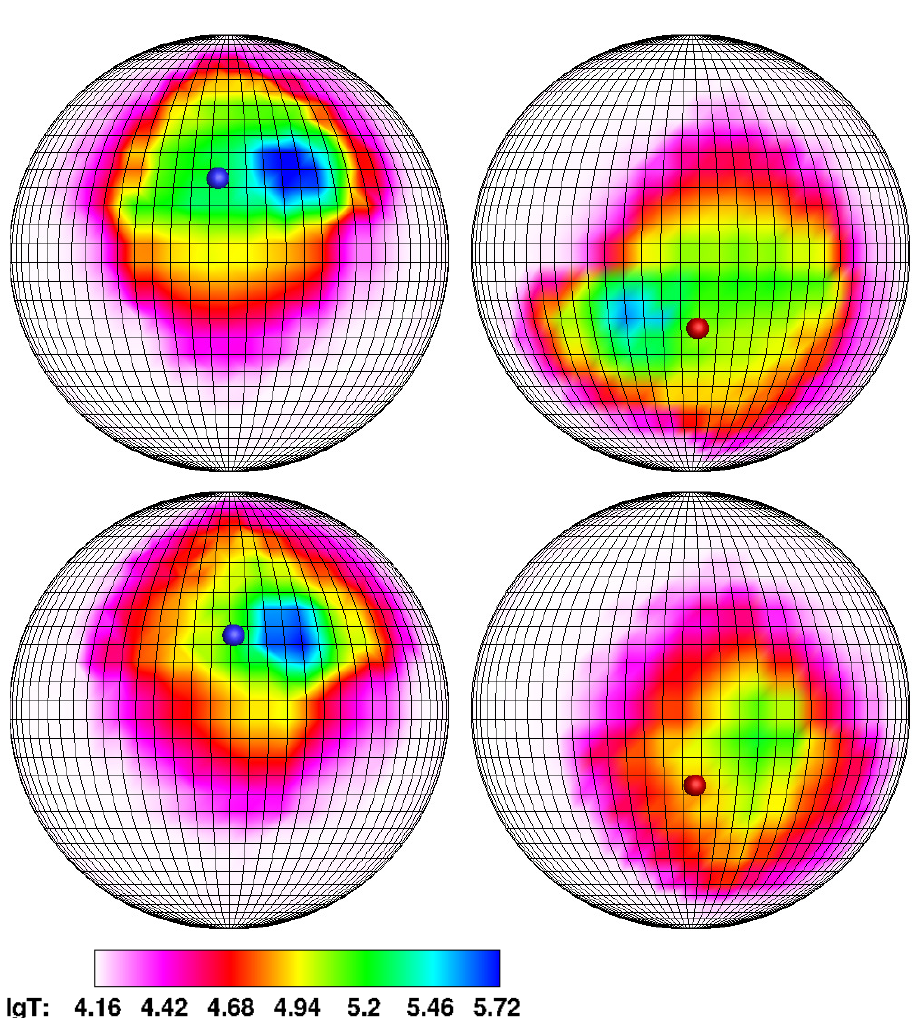
Figure 15. The same as in Figure 14, but for Phase 3 ( upper panel) and Phase 4 ( lower panel). At the formation moment of the arc of matter (Figure 14, lower panel), the deviation of both spots from the magnetic poles does not exceed 15 ◦ . At the same time, the area of the southern spot decreases by two times, and the temperature of the northern spot increases slightly and at this stage is still comparable to the surrounding area. The last circumstance is caused by the fact that although the density of the northern stream is approaching the southern one, the speed of this stream is relatively low at this